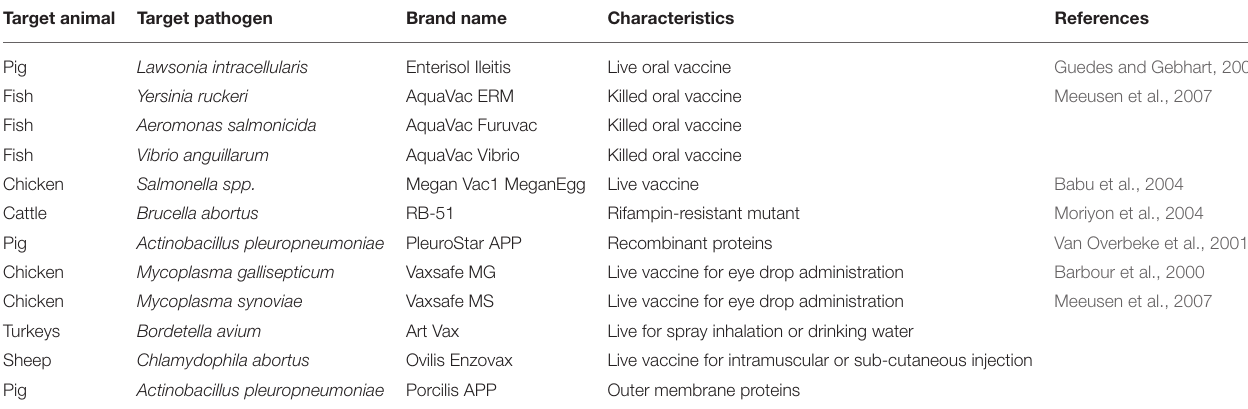
TABLE 4 | List of some available veterinary bacterial